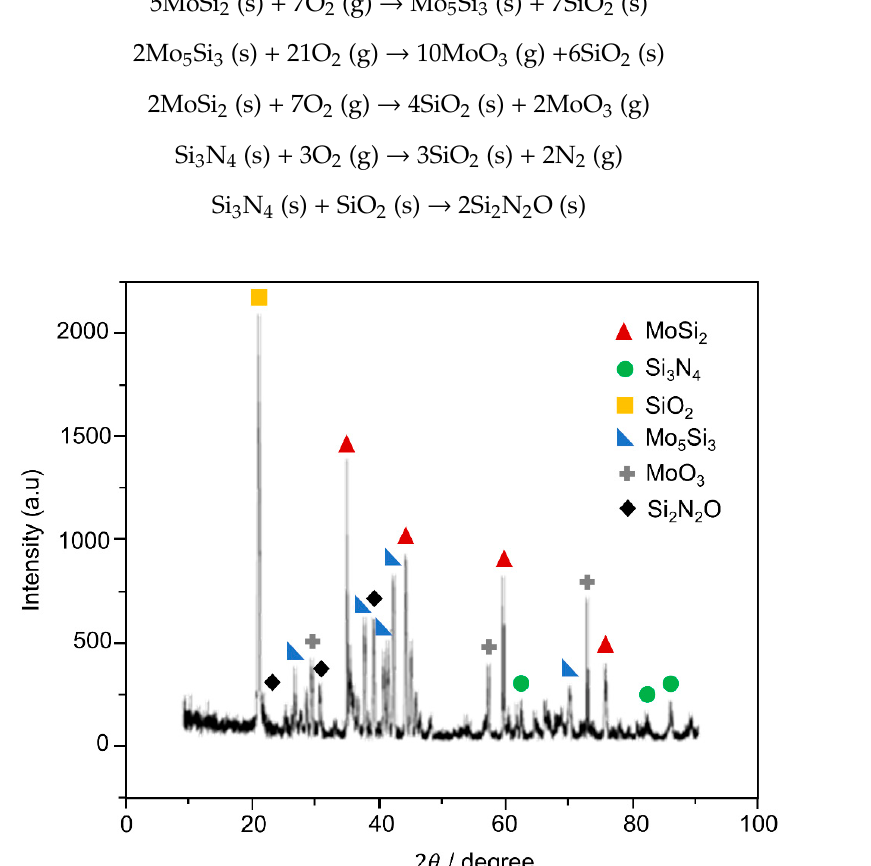
Figure 5. XRD pattern of MoSi 2 -Si 3 N 4 /SiC-coated C/C composites after oxidation at 1773